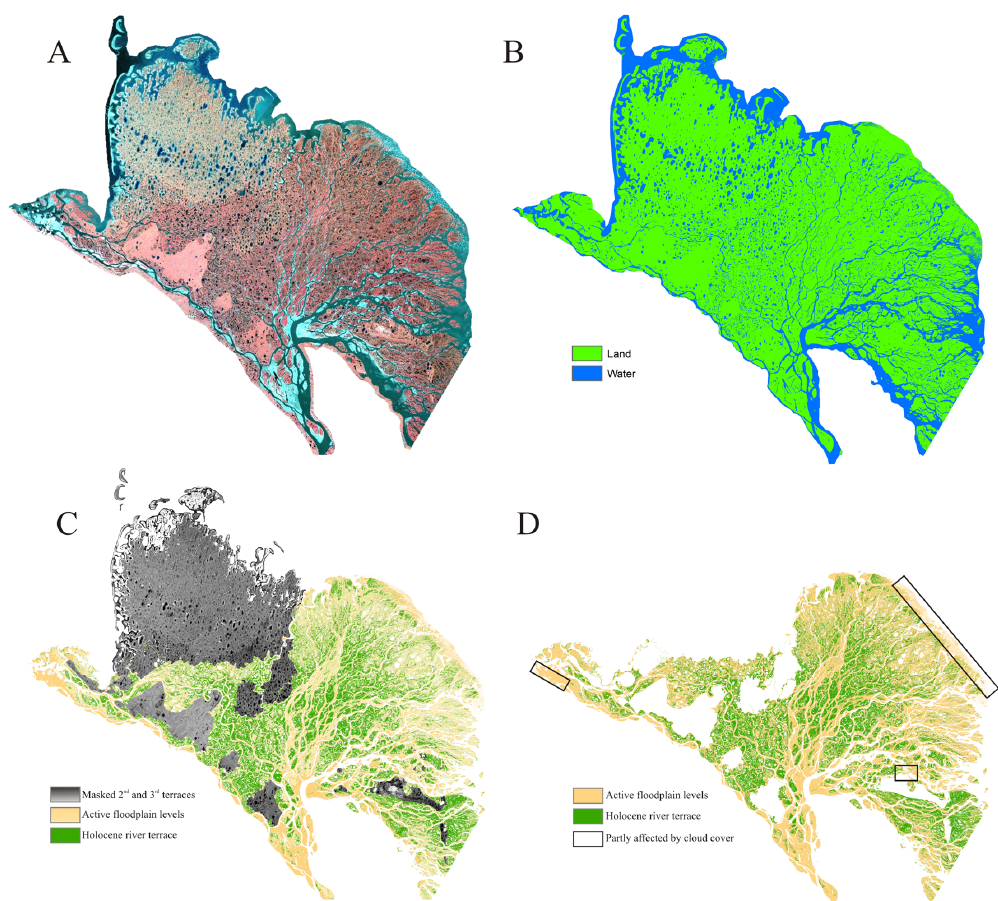
Fig. 9. Landsat-7 ETM + remote-sensing image mosaic of the Lena River Delta from 27 July 2000 and 26 July 2001 (A) , results of land-water classification (B) , results of classification into main geomorphic terraces (C) , and upscaling of soil organic carbon stocks to Holocene river terrace and active floodplain levels (D)